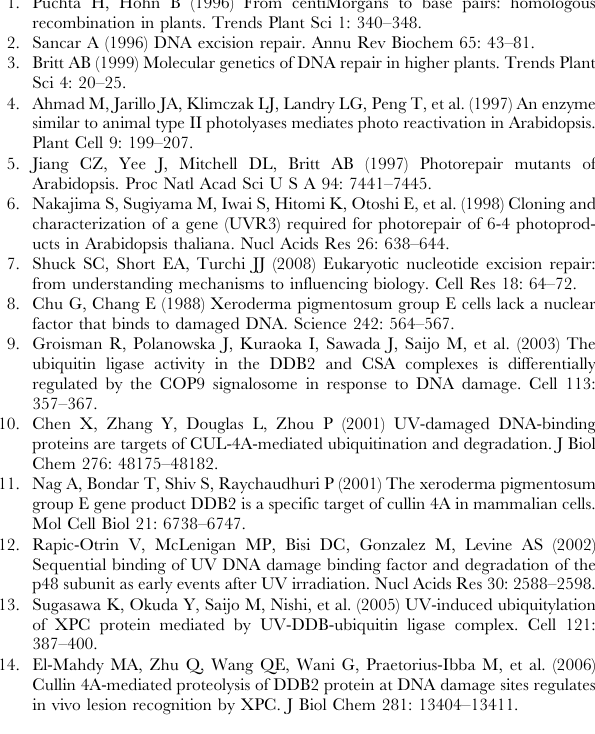
Figure S2 DxR-mutated DDB2 binds DDB1A in yeast. (A) Schematic representation of DDB2 carrying four WD40 domains. The DxR motif at the end of the third WD40 domain is indicated as well as the point mutation R343H used for the yeast two-hybrid assay. (B) Yeast two-hybrid interaction between DDB1A and DDB2 and its mutated version (R343H). No auto-activation by the single plasmids was observed when the yeast strains were grown on LTA medium. Found at: doi:10.1371/journal.pgen.1000093.s002 (0.78 MB TIF) Figure S3 Steady state of GFP-DDB2 protein levels and quantification of DDB2 protein levels upon various genotoxic stresses. (A) Immunoblot revealing GFP-DDB2 content of pOEX4 GFP-DDB2 Arabidopsis transgenic plants upon exposure to UV-C (900 J/m 2 ), Cisplatin (10 m M) and H 2 O 2 (5 mM). Coomassie blue staining was used as loading control. (B) Immunoblot revealing DDB2 content in WT plant up to 2 h following UV-C exposure and the quantification of DDB2 protein levels normalised to the loading controls. (C) Graphs representing the quantification of DDB2 protein levels normalised to the loading controls upon exposure to UV-C in WT plants and in the different mutant backgrounds used. Quantifications are represen- tative of 2 independent experiments, one of them is presented in Figure 6C. Found at: doi:10.1371/journal.pgen.1000093.s003 (0.82 MB